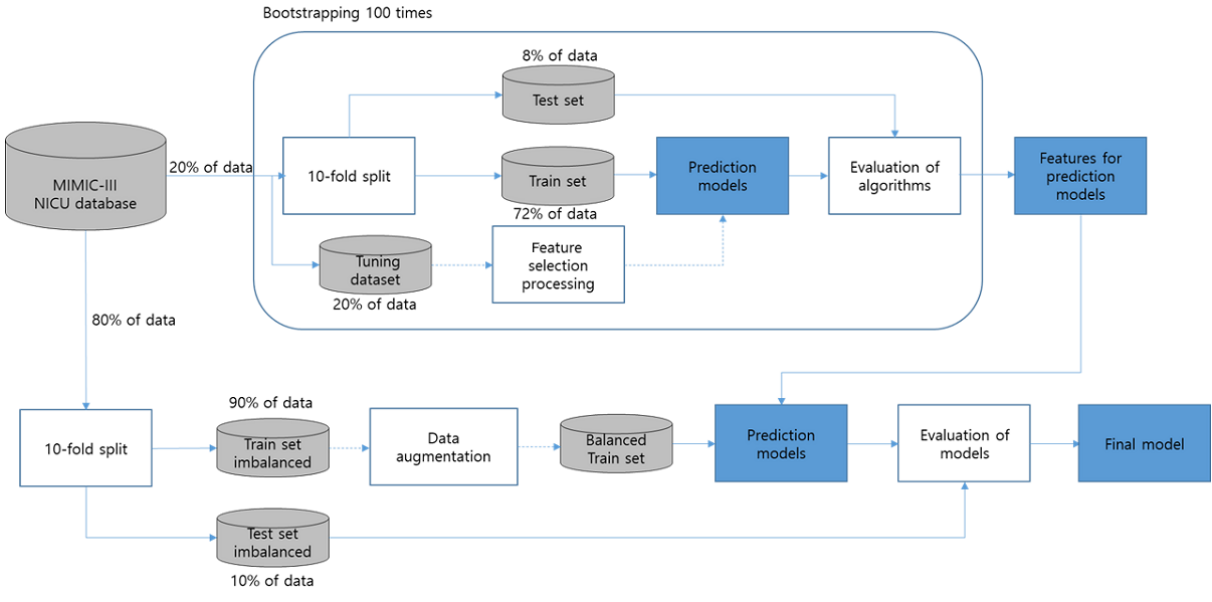
Figure 2. Diagram of the evaluation process for models and algorithms. MIMIC-III: Medical Information Mart for Intensive Care; NICU: neonatal intensive care